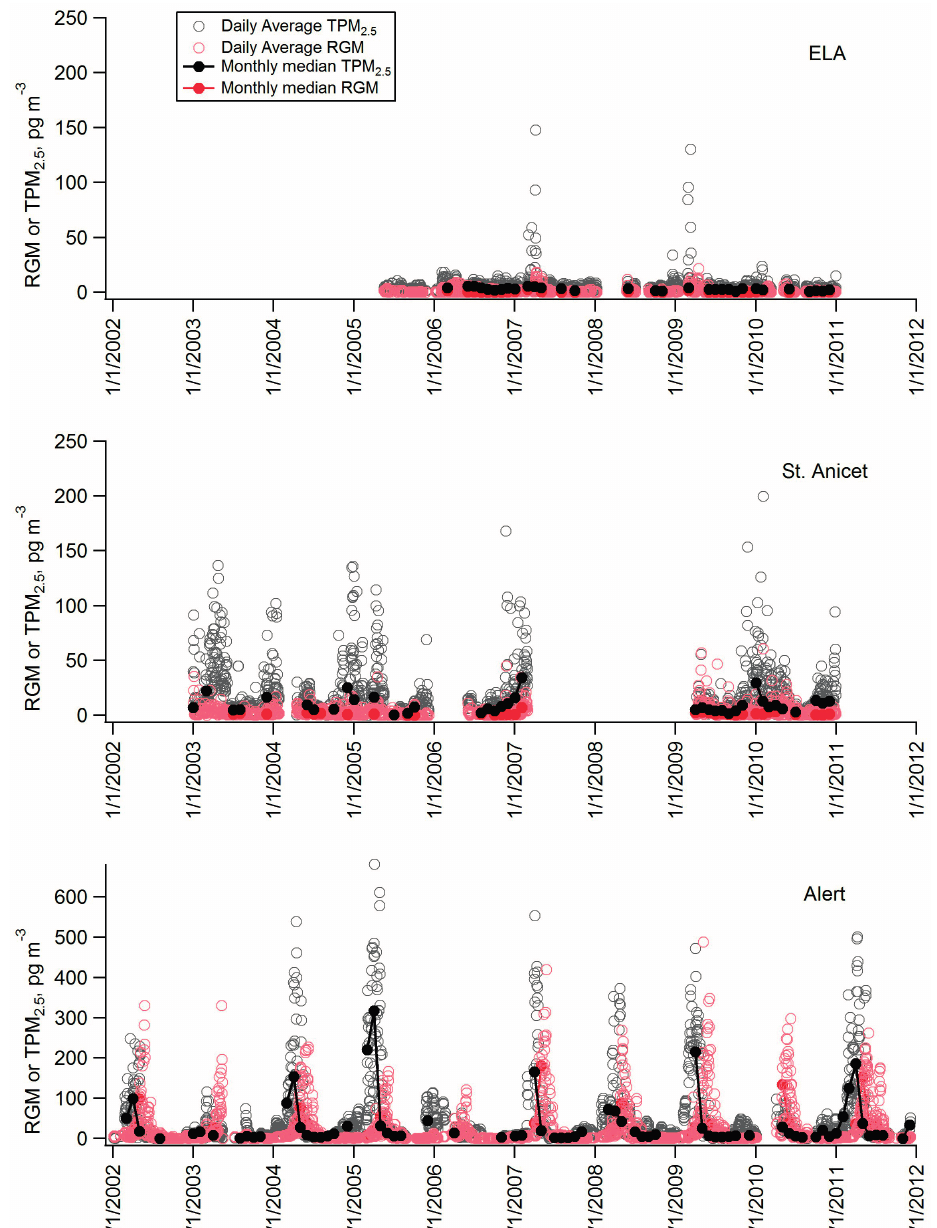
Figure 11. Reactive gaseous mercury (RGM) and total particulate mercury (TPM sites with more than five years of